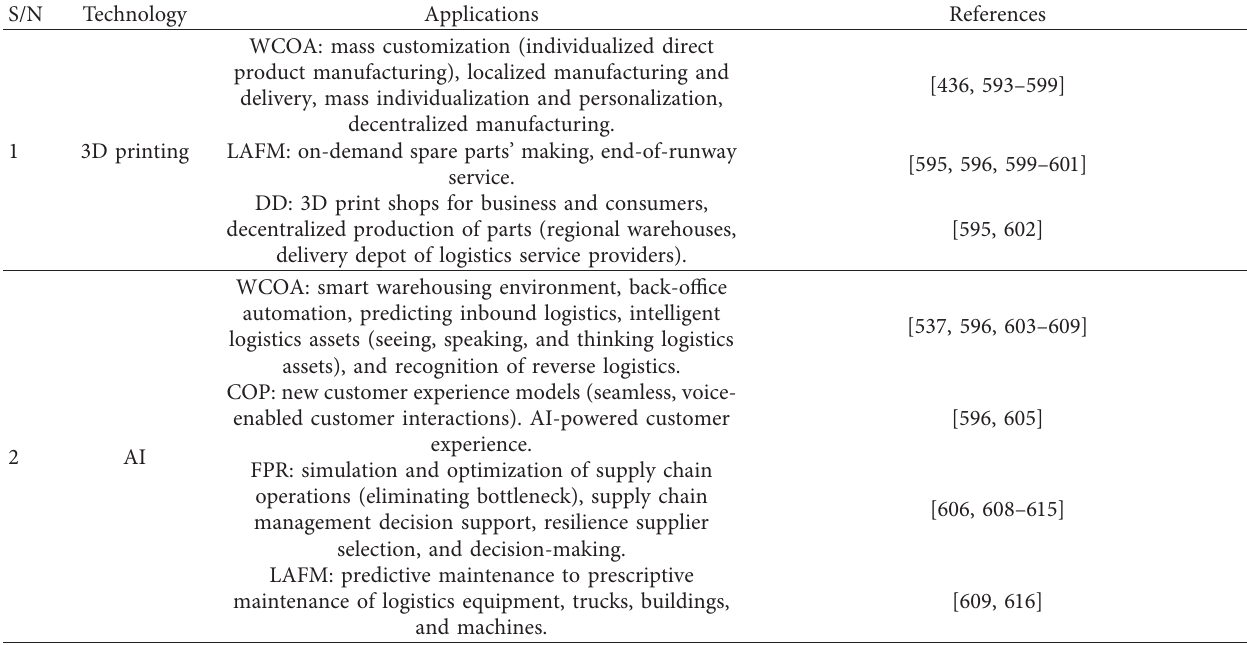
Table 12: Industry 4.0 technology applications in